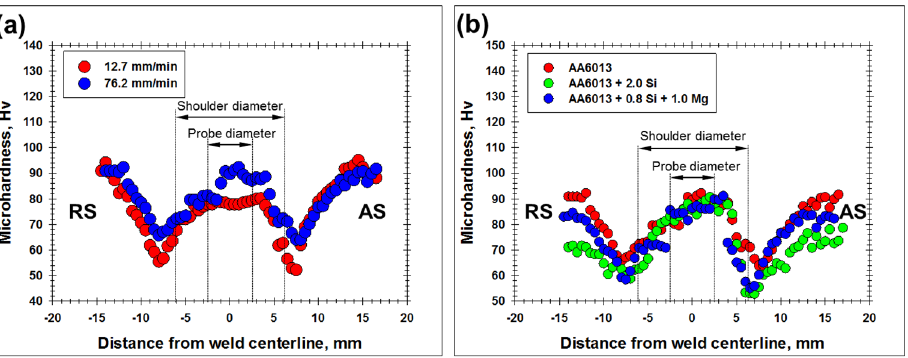
Figure 9. Typical effect of welding speed ( a ) and impurity content in aluminum alloy ( b ) on microhardness profile measured across the mid-thickness of aluminum part of dissimilar joint. In ( a ), microhardness data for AA6013 alloy are shown. In ( b ), welded joints were produced at welding rate of 76.2 mm/min.